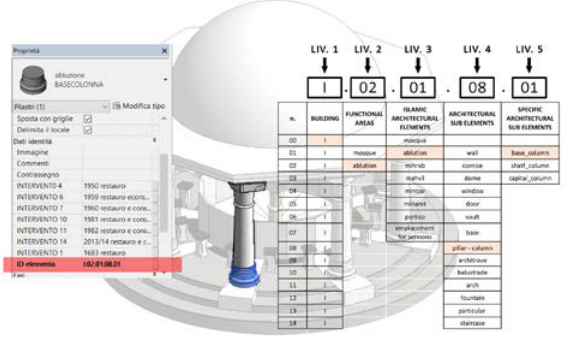
Figure 11. Example of ID code representing the base of the column of the ablution fountain